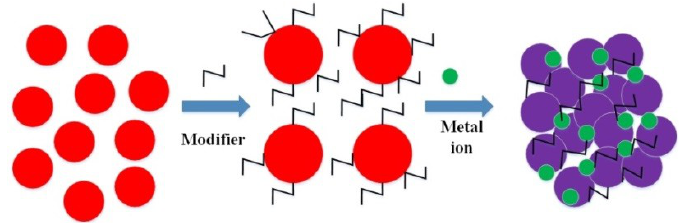
Figure 5. Reaction mechanism of nano gold in detecting heavy metal ions.